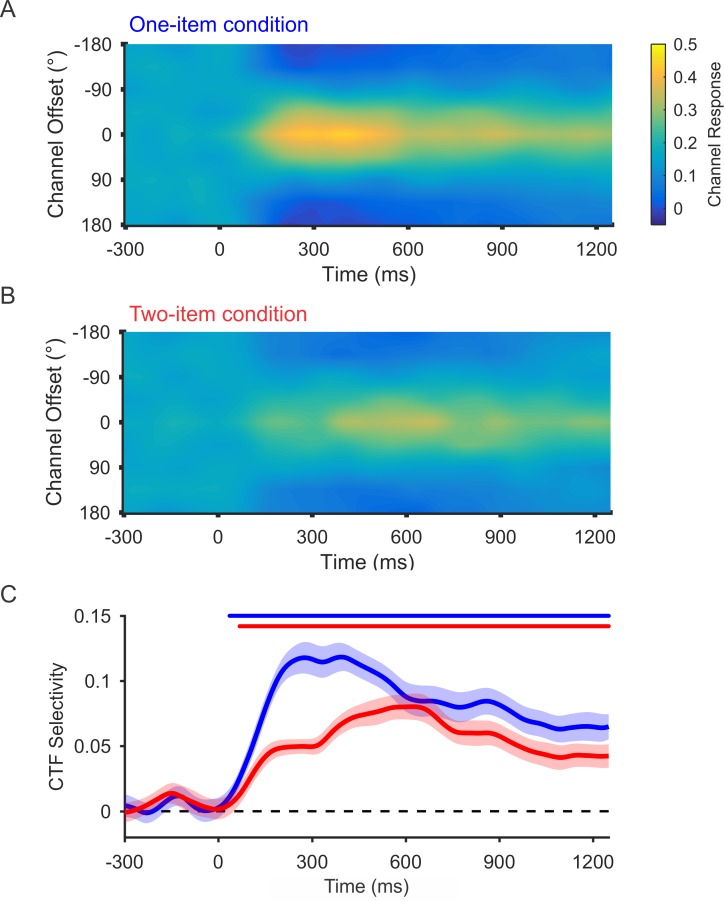
Spatial alpha-band CTFs as a function of memory load.Average alpha-band CTF in the one- and two-item conditions (A and B, respectively). (C) The spatial selectivity of alpha-band CTFs across time (measured as CTF slope, see Materials and methods) as a function of memory load. The blue (one-item) and red (two-item) markers at the top of the panel indicate the period of above-chance selectivity obtained using a cluster-based test. CTF selectivity was reliably higher in the one-item condition than in the two-item condition. The shaded error bars reflect ±1 SEM across observers. Data are available at https://osf.io/47cmn/. CTF, channel-tuning function.